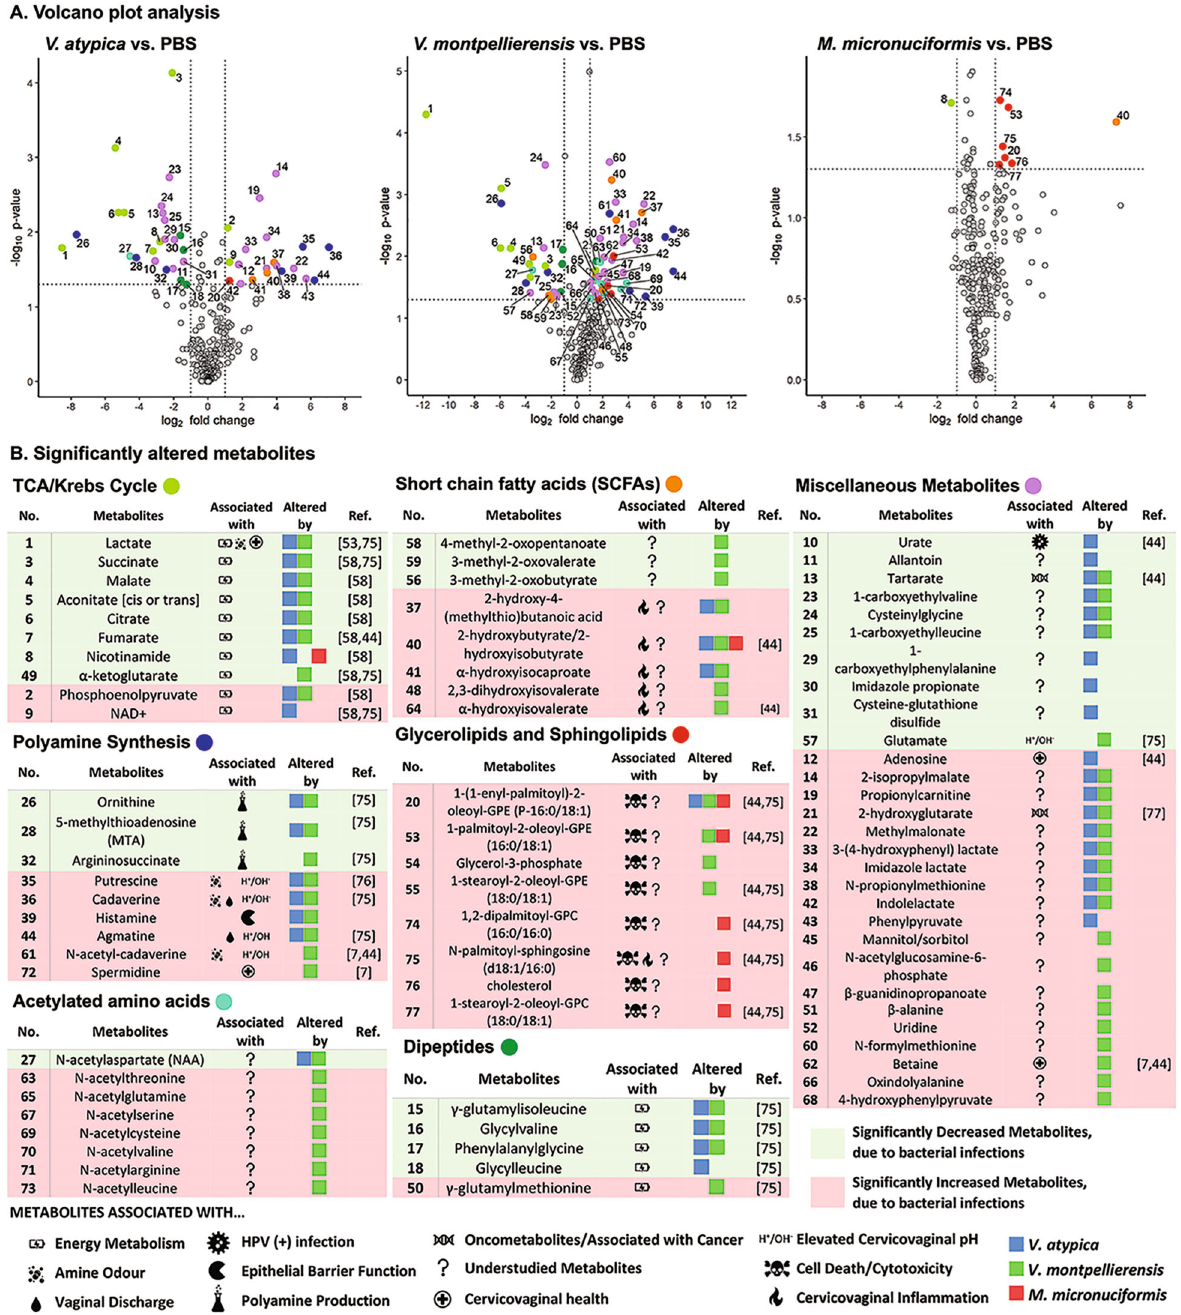
Fig. 5 Metabolites associated with elevated cervicovaginal pH were signi fi cantly altered by V. atypica and V. montpellierensis , whereas metabolites associated with cell death were signi fi cantly accumulated with M. micronuciformis infections. Human 3-D cervical epithelial cells were infected with V. atypica, V. montpellierensis, or M. micronuciformis under anaerobic conditions for 24 h. A Volcano plots of V. atypica , V. montpellierensis and M. micronuciformis metabolic pro fi les. The x axis represents the log 2 fold change values of metabolite scaled intensity values between the infectious treatment and PBS control. The y axis represents the − log 10 ( P ) value of differential metabolite abundance between infectious treatment and PBS controls (paired two-tailed Student ’ s t -test). B Signi fi cantly different metabolites ( P < 0.05) with a fold- change < − 2 or >2 are colored by super pathway. Symbols indicate how the metabolite may impact BV pathogenesis. See Supplementary Data 1 for speci fi c P -values, q -values, and mean fold changes of all measured